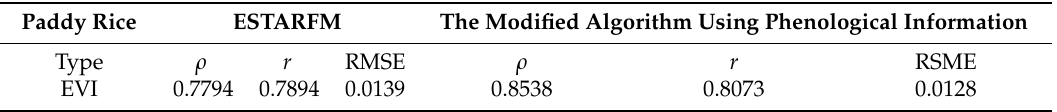
Table 3. Regression coefficient of the linear fitting equation, correlation coefficient, and root mean square error of EVI of predicted reflectance compared with real reflectance, for paddy rice.